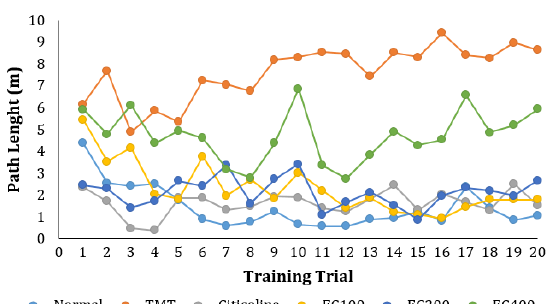
Figure 1. The mean latency (seconds) of rats in all treatment groups during 20 exercises in the MWM acquisition trial